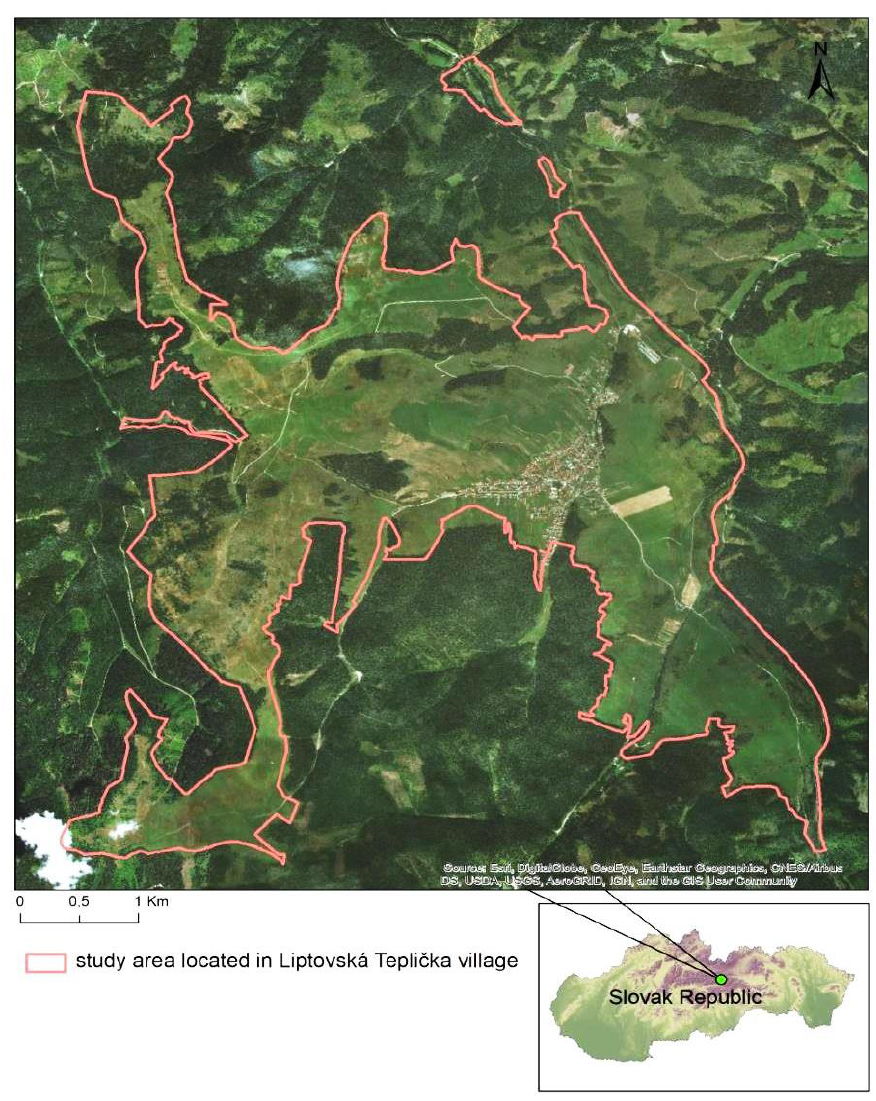
Figure 2. Geographical situation of the study area of Liptovská Teplička cadastre. Source: Base map,